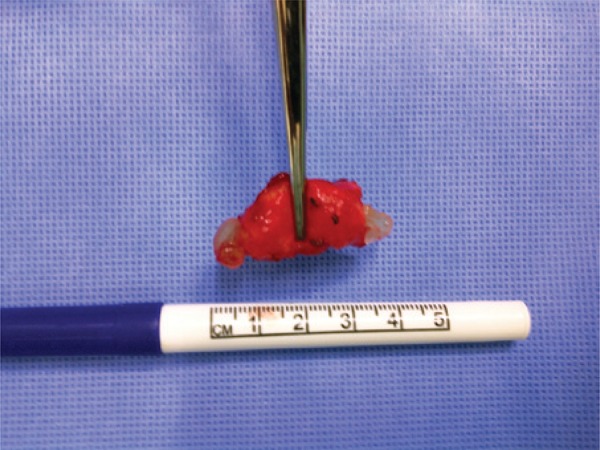
Espécime cirúrgico